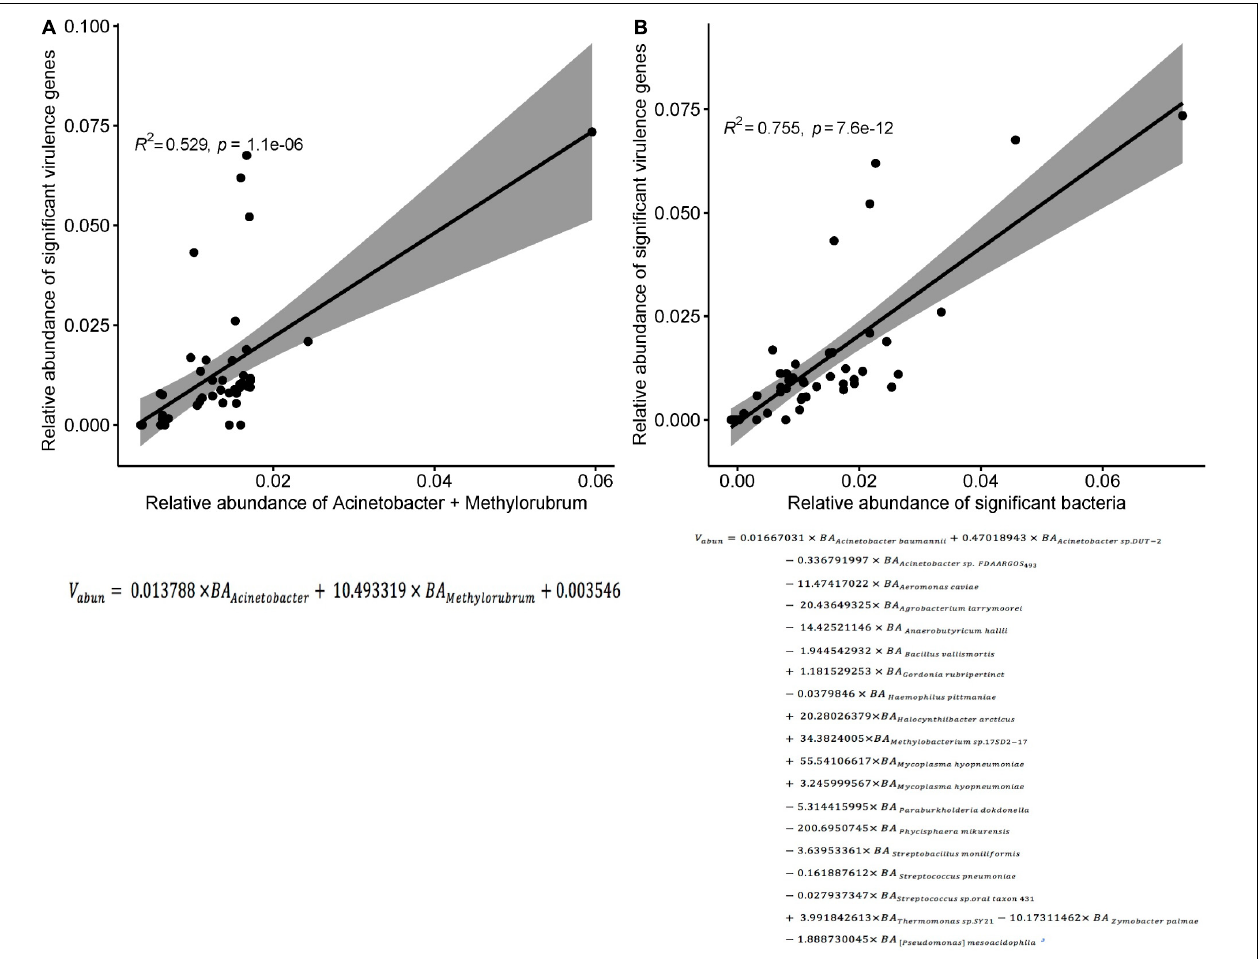
FIGURE 7 | Correlation between the sum of the relative abundances of genus or species and the significant virulence genes density. (A) Correlation between the sum of the relative abundances of Acinetobacter and Methylorubrum and the significant virulence genes density in each sample (R 2 = 0.529, p < 0.0001; Pearson’s correlation). (B) Correlation between the sum of the relative abundances of species and the significant virulence genes density in each sample (R 2 = 0.755, p < 0.0001; Pearson’s correlation). V abun , Sum of abundance of significant virulence genes; BA i : abundance of bacteria i